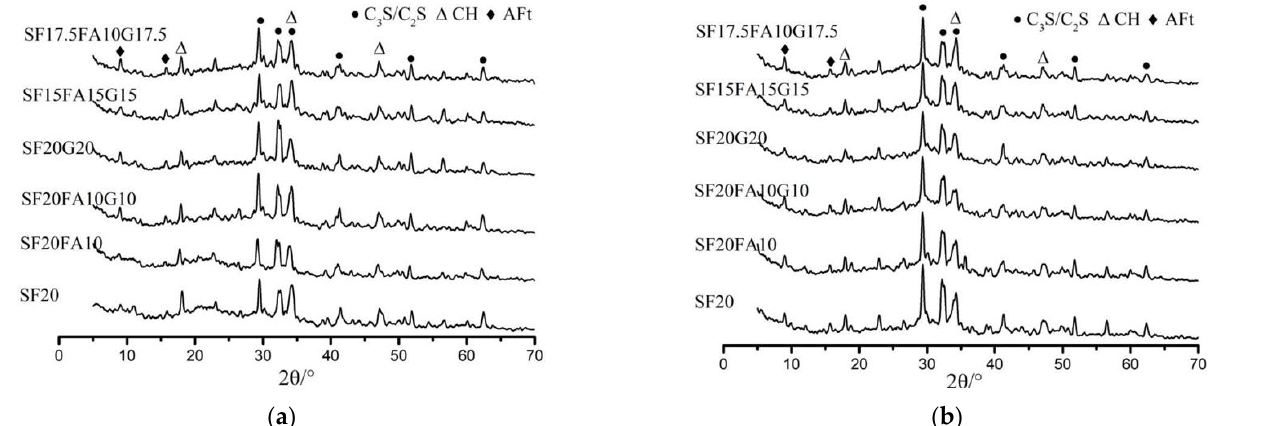
( d ) Figure 3. Compressive and flexural strength of EUHPC under different curing regimes: ( a ) com- pressive strength at 7 days; ( b ) compressive strength at 28 days; ( c ) flexural strength at 7 days; ( d ) flexural strength at 28 days. 3.3. XRD Analysis 3.3.1. XRD Analysis of EUHPC under Standard Curing The XRD spectra of EUHPC under standard curing at 7 days and 28 days are pre- sented in Figure 4. It is clear that the diffraction peaks of C 3 S and C 2 S were significant for all specimens at 7 days and 28 days due to the relatively low water/binder ratio of EUHPC. Theoretically, the water demand for the complete hydration of cement is 23 – 25% of its weight, but many factors may influence the actual hydration of cement; the actual water requirement is about 42%, which is far higher than the theoretical value. The results of the hydration test of UHPC with the water/binder ratio of 0.16 indicated that the hydration degree of cement at 28 days was only 57.5%, with nearly half of the cement remaining